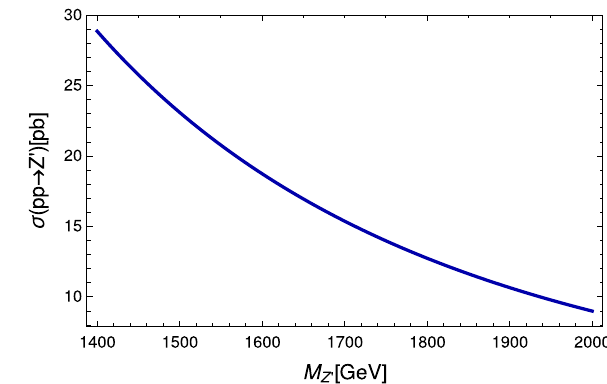
√ S = 100 TeV and g X = 0 . 1 as a function of